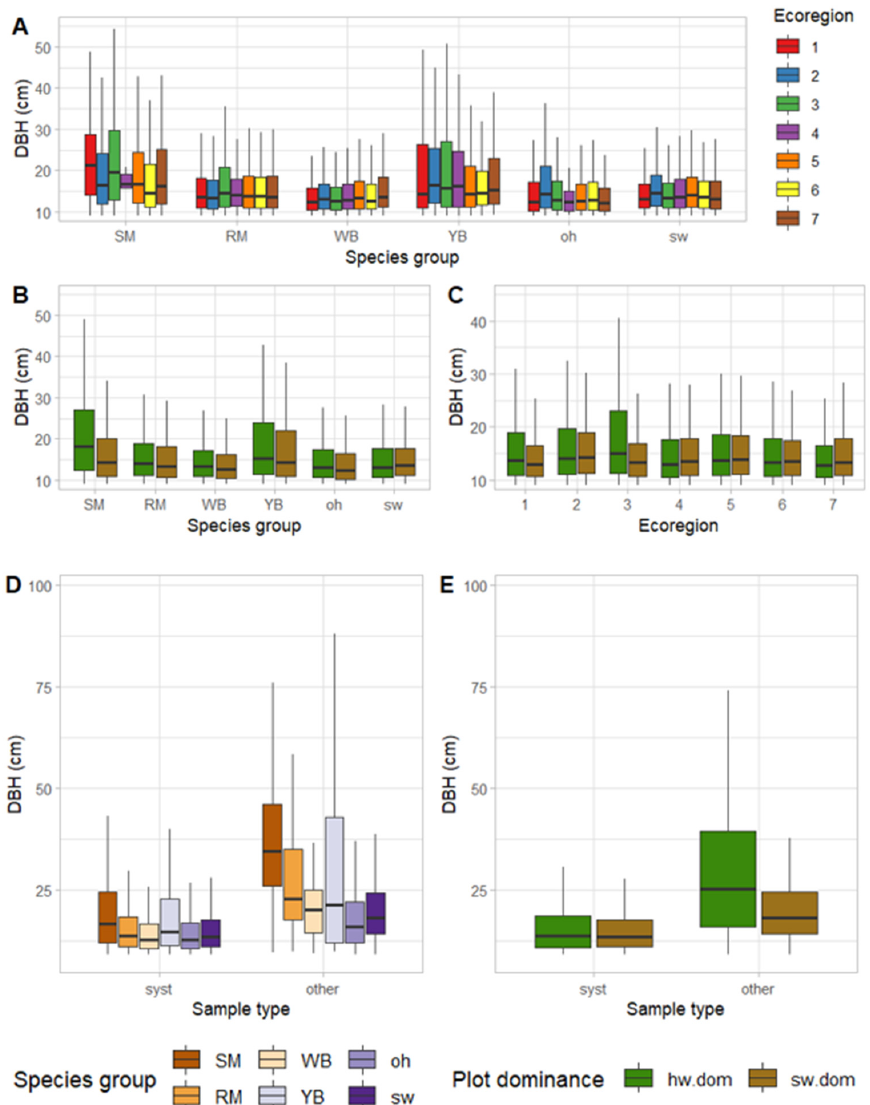
Figure 8. DBH of trees (N = 253,235) depending on species group (SM: sugar maple; RM: red maple; WB: white birch; YB: yellow birch; oh: other hardwoods; sw: softwoods) and ecoregions (1 to 7) ( A ), species group and plot dominance (hardwood dominated (“hw.dom”) or softwood dominated (“sw.dom”)) ( B ), ecoregion and plot dominance ( C ), sample type (systematic “syst” or other) and species group ( D ), and sample type and plot dominance ( E ). Outliers have been removed from graphical representation to enhance readability of